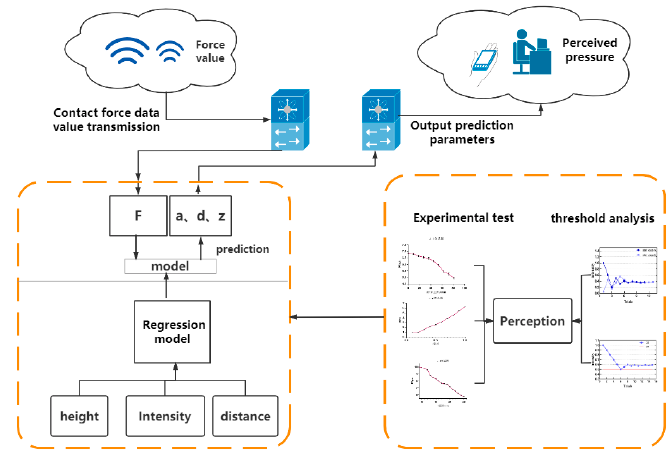
Figure 11. Frame diagram of real-time force feedback system.